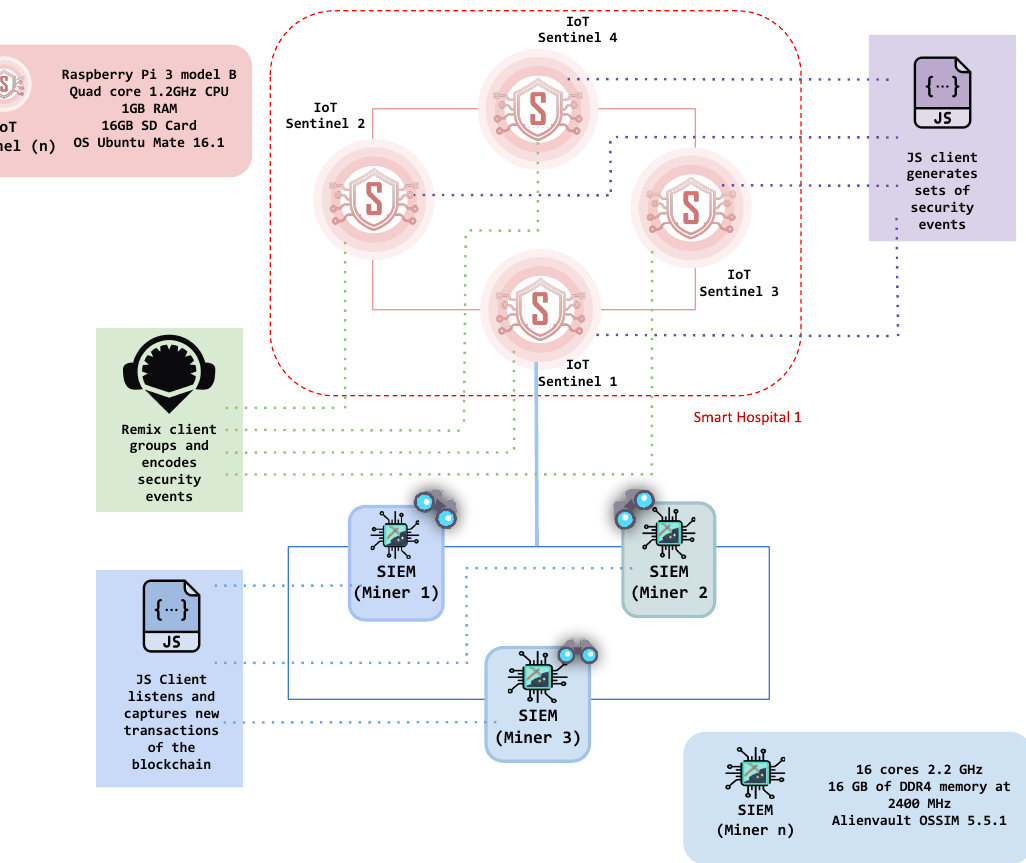
Figure 5. Scenario for the execution of experiments.